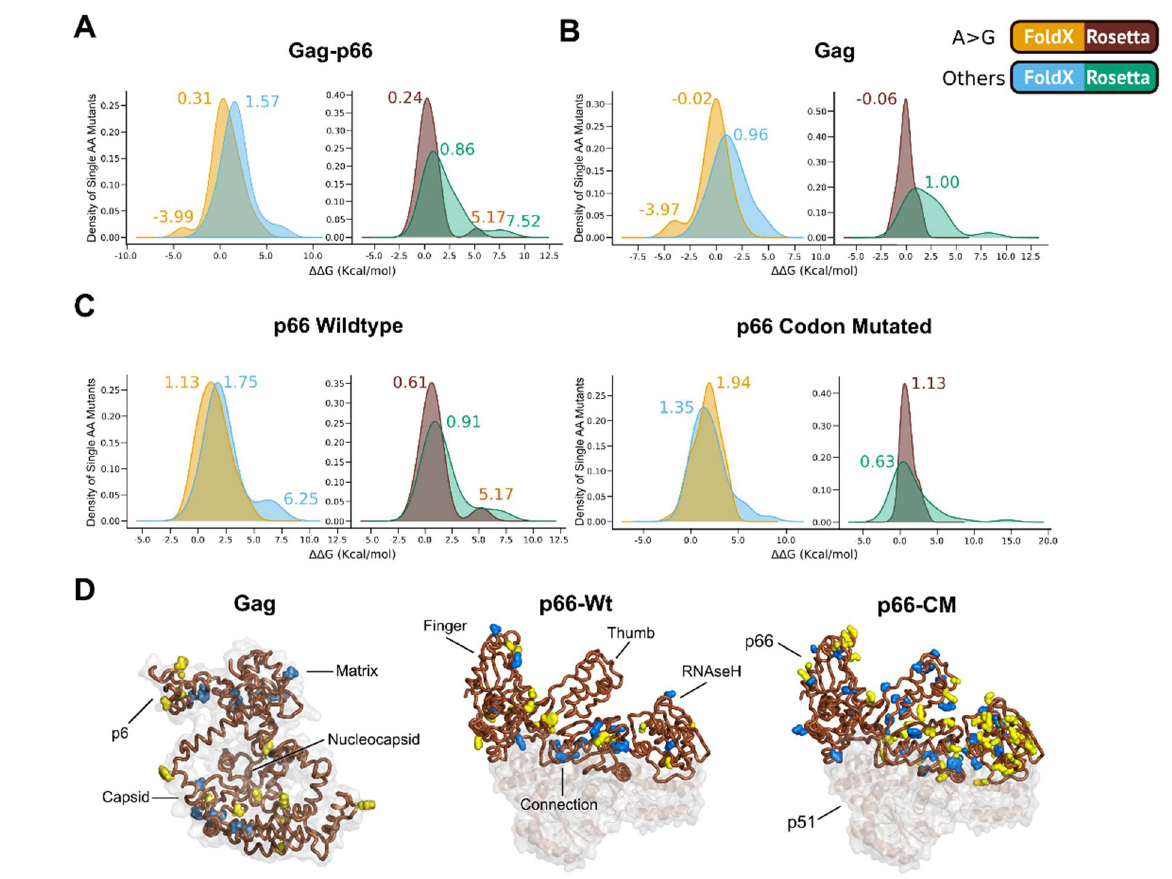
Figure 6. Distributions of the change in mutational free energies (ΔΔG) of pooled mutations. Density plots showing distributions of ΔΔG of all individual amino acid mutations (including hypermutations) from ( A ) Gag-p66, ( B ) Gag ( C ) wild-type RT p66 (p66-Wt) and codon mutated RT p66 (p66-CM) genes. ( D ) Positions of ‘A to G’ mutations in the protein structures of Gag and p66 are shown in yellow while all other mutations are in blue. There were both ‘A to G’ and ‘other’ mutations at position 462 of p66-CM labeled blue. The C and N terminals and locations of major domains and functional protein regions are shown with labels. Peaks are numbered with corresponding ΔΔG values. The mutational free energies were modeled with the Rosetta Cartesian_ddg and FoldX BuildPDB protocols. ΔΔG values or ΔΔG differences between different distributions of >1 kcal for Rosetta (29) and ΔΔG > 0.46 kcal/mol for FoldX (30) were significant. Note that Gag exists in both the compact and extended states and since the former precedes the later during viral assembly, the former was used.